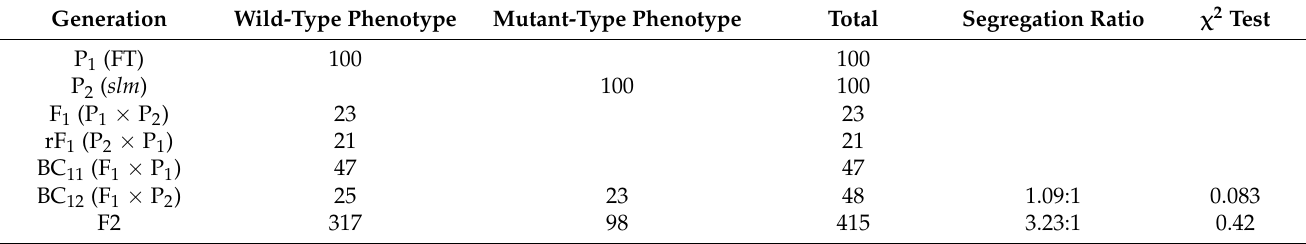
Table 1. Genetic analysis of slm in Chinese Cabbage.